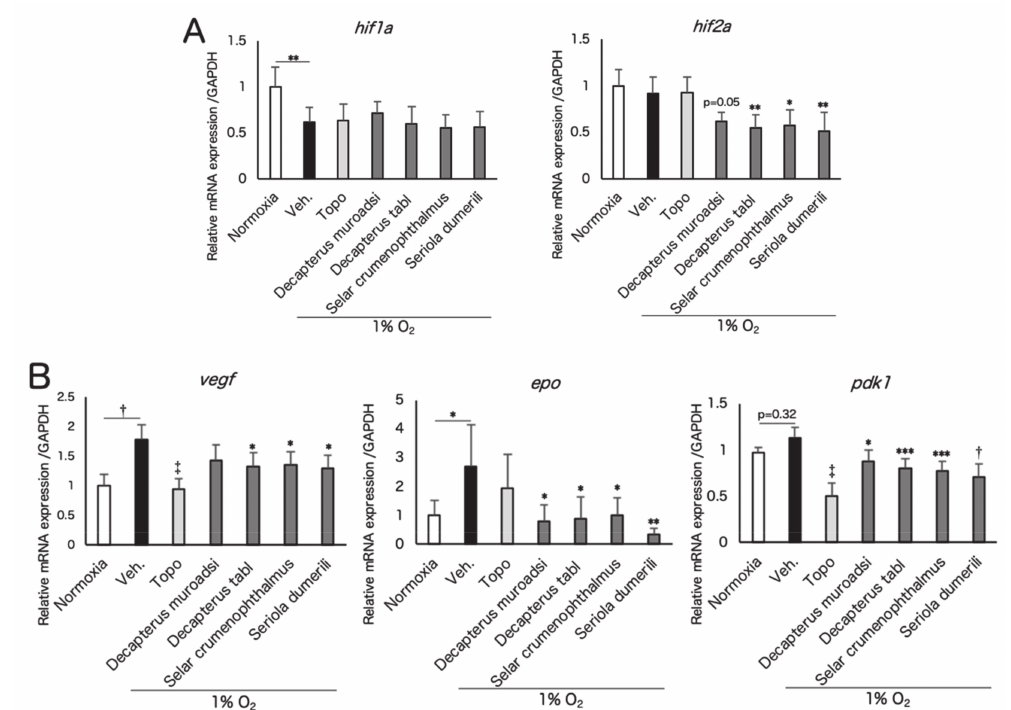
Figure 2. Fish ingredients suppress HIFs and their target genes associated with angiogenesis in vitro. Real-time PCR was performed for hif-1a and hif-2a ( A ) and their target genes, including vegf , epo , and pdk1 , under 1% O 2 conditions in ARPE19 cells ( B ). Note that gene expression of hif-2a was suppressed by fish ingredients. Vegf , epo , and pdk1 were upregulated under 1% O 2 conditions and significantly suppressed by fish ingredients administration. Fish ingredients were added at 1 mg / mL and the hypoxic conditions were maintained for 12 h. n = 6 / group. * p < 0.05, ** p < 0.01, *** p < 0.001, † p < 0.0001, ‡ p < 0.00001 compared with 1% O 2 / vehicle. Error bars indicate mean plus SD. Veh., vehicle; Topo, topotecan; epo, erythropoietin.